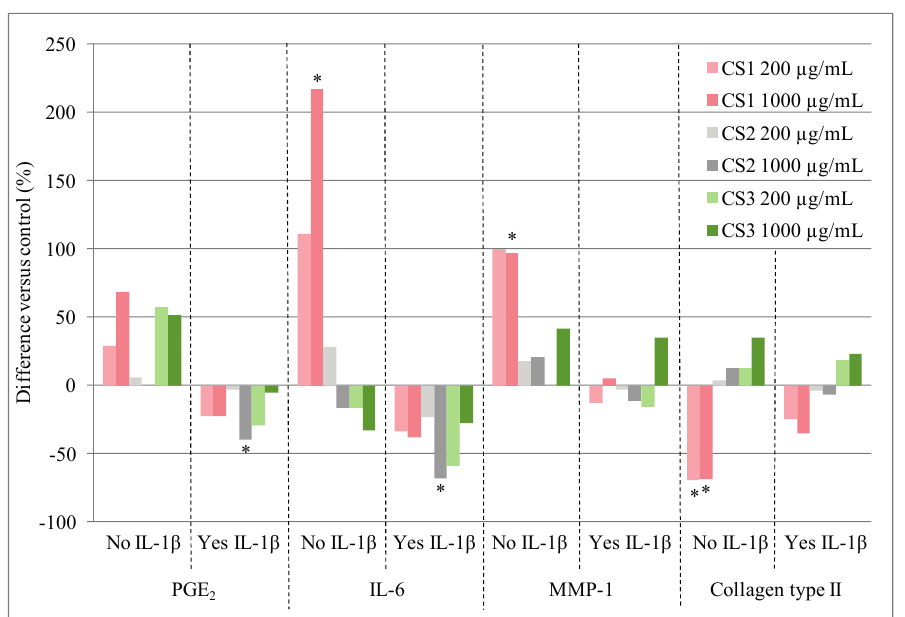
Figure 2. Effects of three chondroitin sulfate (CS) formulations on human osteoarthritic chondrocytes in the absence and presence of IL-1 β . Adapted with permission from Tat et al. , * p <